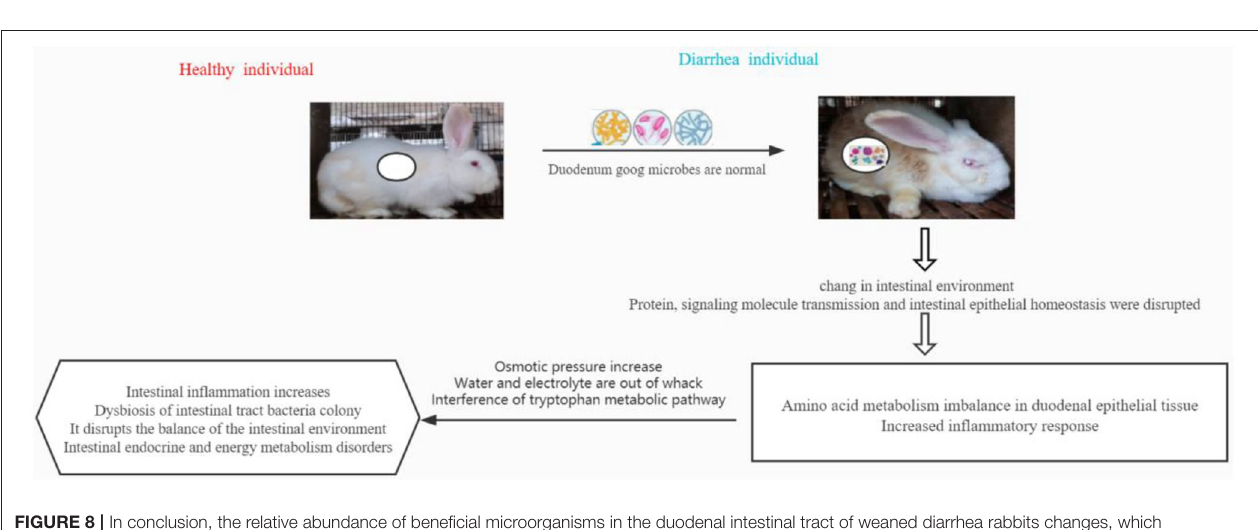
FIGURE 8 | In conclusion, the relative abundance of beneficial microorganisms in the duodenal intestinal tract of weaned diarrhea rabbits changes, which subsequently changes the microbiological environment and immune gene regulation of the duodenal intestinal tract, leading to the imbalance of amino acid metabolism in epithelial tissues and intensified inflammatory response. Further manifestations are elevated osmotic pressure, water and electrolyte imbalance, and endocytosis of intimal proteins, leading to altered pathways of intestinal metabolites. These results mainly show intestinal inflammation and imbalance in the bacterial population of the intestinal tract, disruption of intestinal environmental balance, and disruption of intestinal endocrine and energy